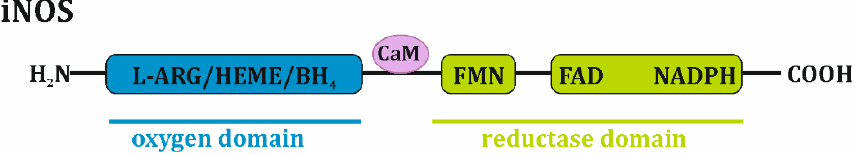
Figure 1. Domain-structured scheme of iNOS monomer. iNOS monomer is composed of oxygen domain that associates L-arginine (L-ARG), protoporphyrin IX (HEME) and tetrahydropterin (BH4), as well as reductase domain that consists of flavin mononucleotide (FMN), flavin adenine dinucleotide (FAD) and reduced form of nicotinamide adenine dinucleotide phosphate (NADPH). Calmodulin (CaM) is noncovalently bound to the iNOS complex.